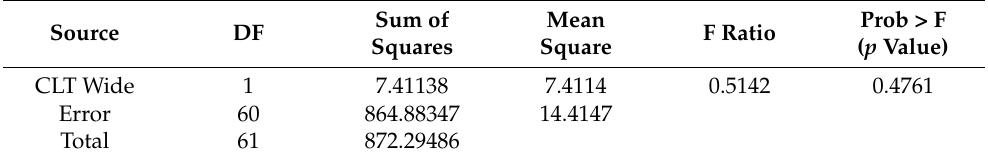
Table 3. ANOVA test results for the compressive strength of CLT. Source DF